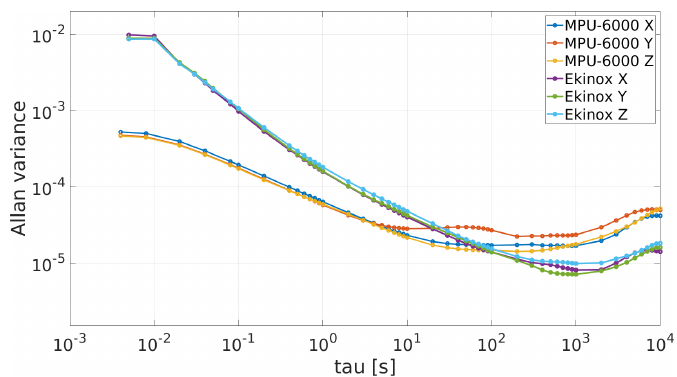
Figure 3. Allan variances plots for gyroscopes.